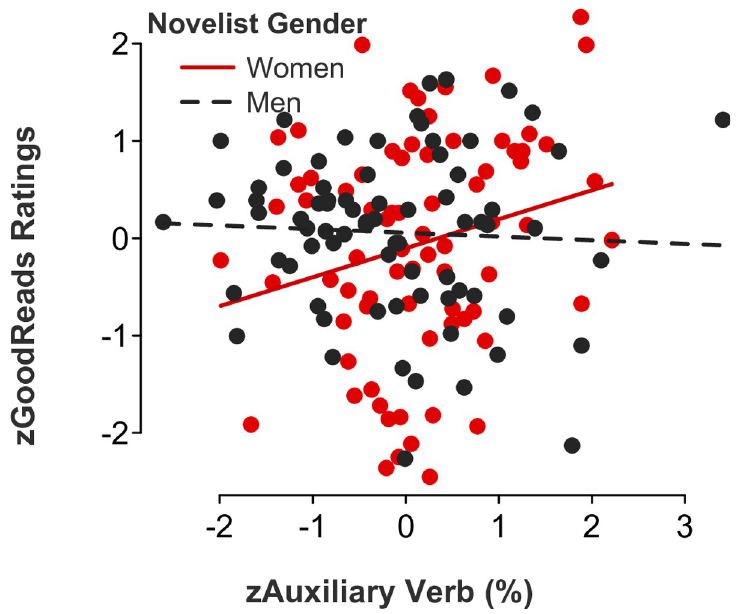
Fig 8. Novel ratings as a function of auxiliary verb use and novelist